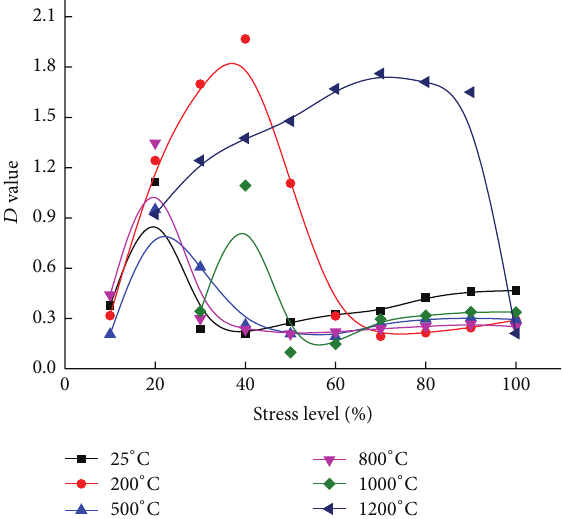
Figure 11: The maximum and minimum 𝐷 values before peak strength after different temperatures.